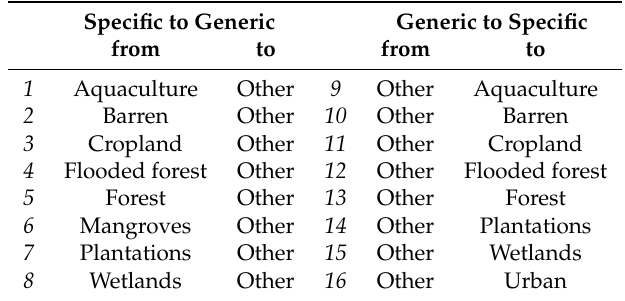
a specific class to any other. The right column, the ‘Generic to Specific’ category (9–16), includes transitions from any class into a specific class. Each category contains 8 classes. Specific to Generic Generic to Specific from